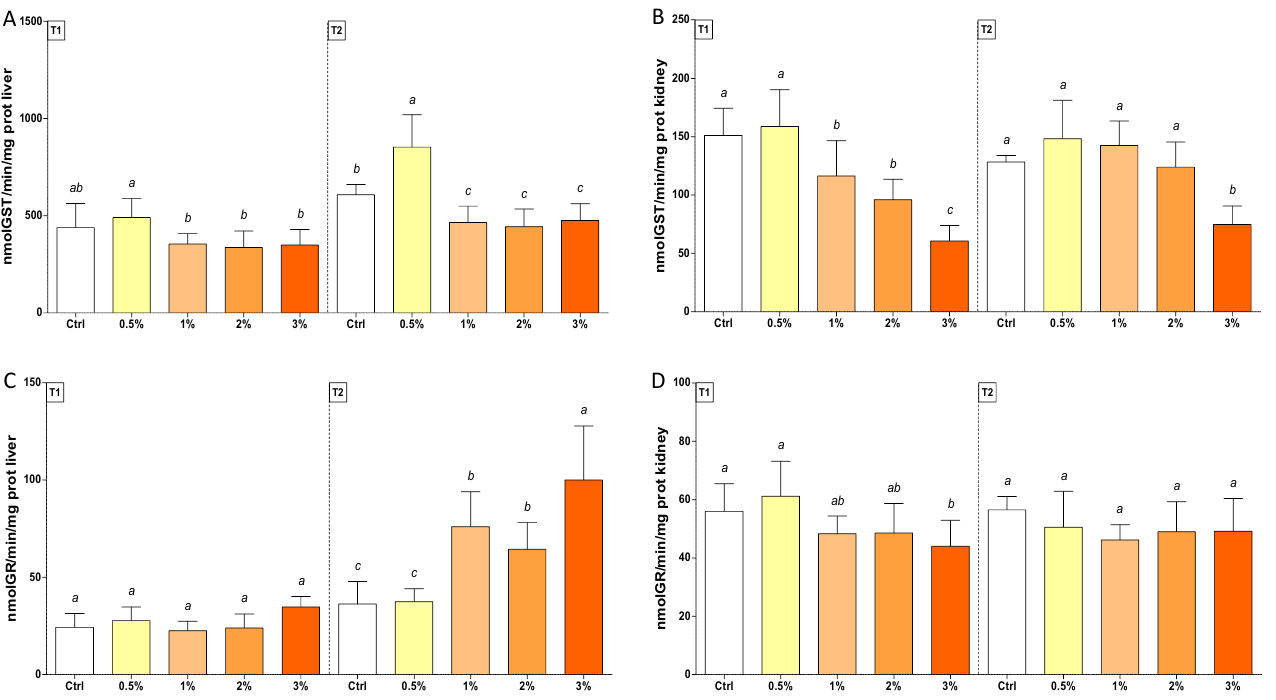
Figure 3. Enzymatic activity of GST (Panel ( A , B )) and GR (Panel ( C , D )) in livers (on the left, Panel ( A , C )) and kidneys (on the right, Panel ( B , D )) of rainbow trout Oncorhynchus mykiss fed with F1-BEO-supplemented diets (0.5%, 1%, 2%, 3% ( w / w ) supplementation) after 15 (T1) and 30 (T2) days. Different lowercase letters indicate statistically significant differences among experimental groups ( p < 0.05) for each experimental endpoint. In the same tissue, GI levels were consistently lower than control (80%) in trout exposed to 1–2–3% ( w / w ) F1-BEO diets. On the contrary, enhanced enzyme activity was observed in 0.5% ( w / w ) F1-BEO-treated trout in T2. In livers, a consistent depletion in GI activity was measured in T2 in fish fed with 1–2–3% ( w / w ) F1-BEO diets (Figure 4, Panel A and B). A transient decrease (30%) in GII activity was observed in kidneys of trout treated with 1–2–3% ( w / w ) F1-BEO diets, whereas a late depletion (30%) occurred in fish exposed to 0.5% ( w / w ) of the same extract (Figure 4, Panel D). LDH levels were enhanced (1.5-fold) in trout fed with 0.5% ( w / w ) and lowered (80%) in the other treated groups in the liver. In kidneys, enzyme activity was consistently depleted (40%) in trout fed with 3% ( w / w ) F1-BEO (Figure 4, Panel E and